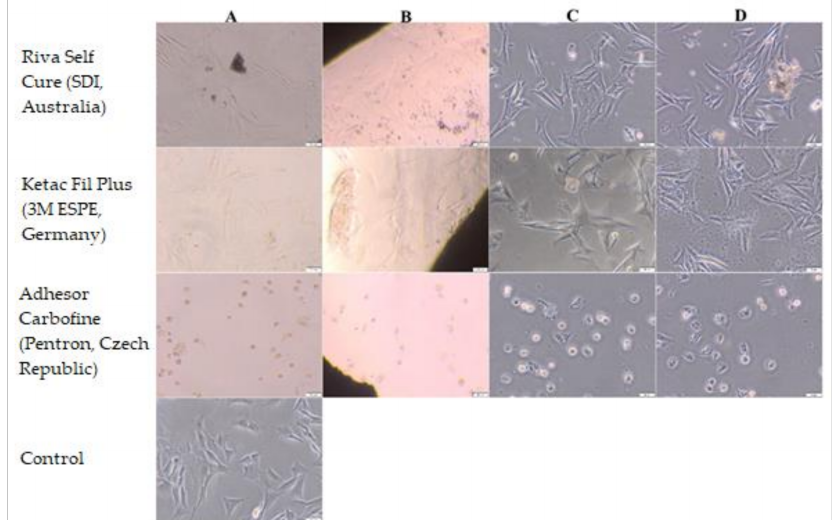
Figure 7. Morphology of Balb/3T3 cells after 24 h of contact with Riva Self Cure (SDI, Australia), Ketac Fil Plus (3M ESPE, Germany) and Adhesor Carbofine (Pentron, Czech Republic); ( A ) under and ( B ) near the cement, ( C ) in area up to 1 cm, ( D ) in area more than 1 cm. Control culture had no contact with the test materials. Magn. 100 × . Table 3. Assessment of cytotoxic activity of the tested materials—in vitro tests on the Balb/3T3 line. Cell Culture Cement Morphological Changes in Cell Culture Evaluation cells degeneration and lysis observed under the